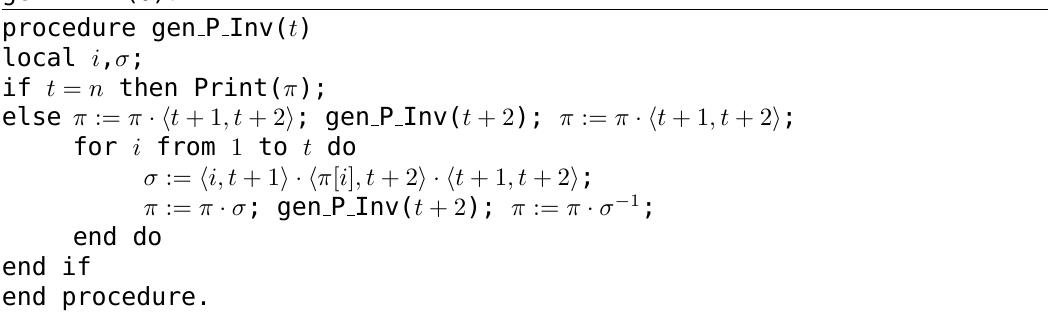
Algorithm 5 Procedure generating length- n pure involution. Initially π = 1 2 3 . . . n and the main call is gen P Inv( 0 )